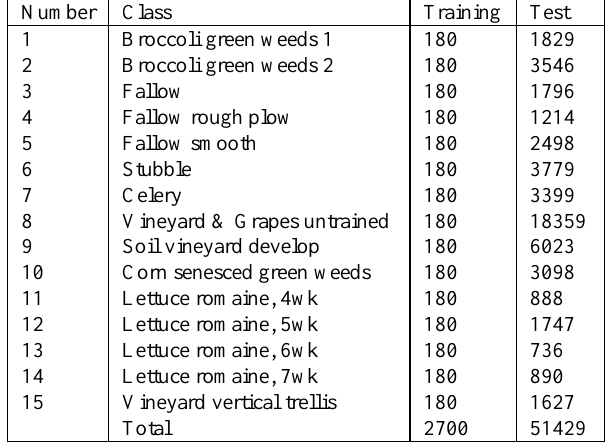
Table 1. Number of training and test samples used in the Salinas scene dataset.